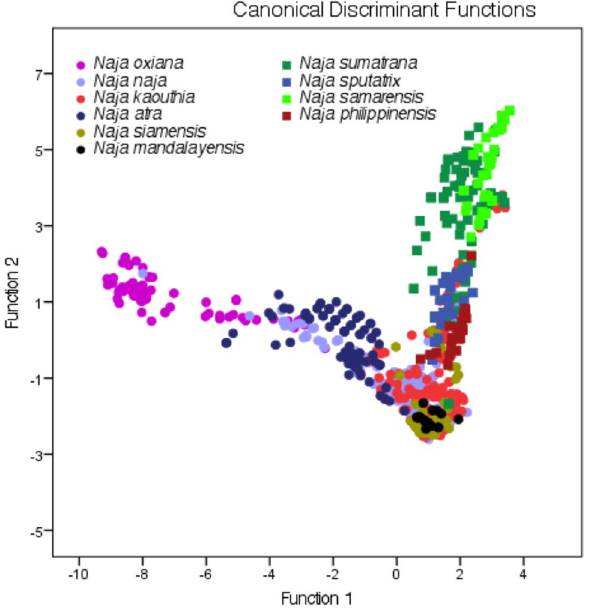
Figure 4. Clusters of 1162 occurrence points of ten Naja species. The solid circle is presenting species mostly distributed in Mainland and solid squares are presenting species distributed in Insular Southeast Asia.